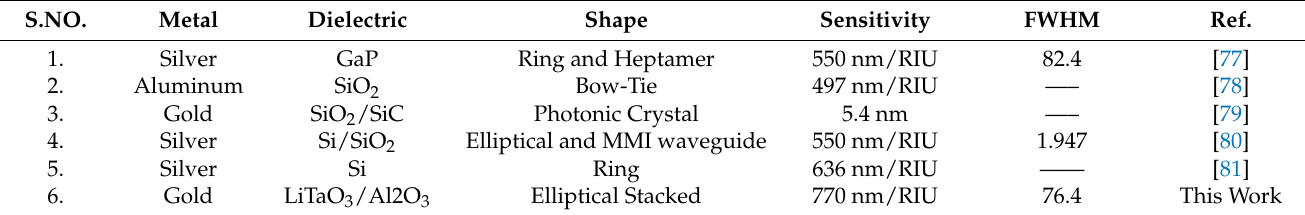
Table 2. Comparision between the proposed work and the other metallic and hybrid